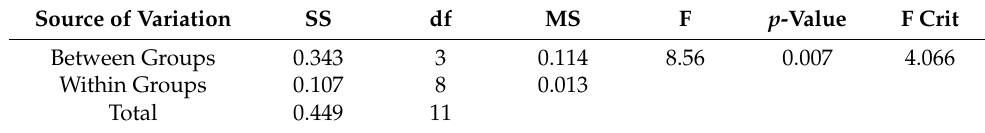
Table 6. One-factor ANOVA for effect of treatment on infiltration rate ( p = 0.05).